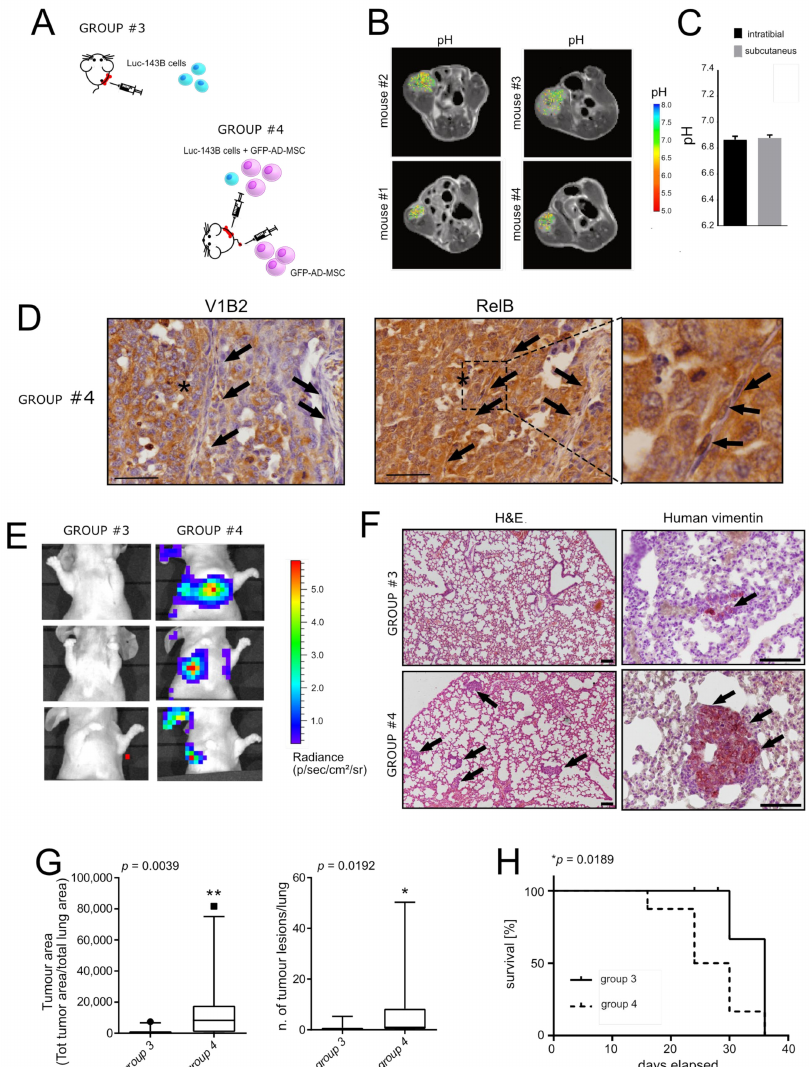
Figure 3. Intratumoural acidosis and co-injection with GFP-AD-MSC in intratibial OS promotes the expression of IL6 and fosters lung metastasis. ( A ) Representative scheme of the experimental animal trial n. 3 (see Table 1); ( B ) Representative tumour extracellular pH maps for intratibially injected OS xenografts, as measured by CEST-MRI; ( C ) Comparison of the intratumoural pH value of subcutaneously injected xenograft with luc-143B cells (group #1, see Table 1), and intratibially injected xenografts with luc-143B/GFP-AD-MSC (group #3, see Table 1), as measured by CEST-MRI (Mean ± SEM); ( D ) Representative images of the immunostaining of V1B2 V-ATPase and of RelB of intratibially injected xenograft after the co-injection of GFP-AD-MSC and luc-143B OS cells (group #3, see Table 1). RelB immunostaining image with further magnification is shown in the right rectangle (arrows indicate fibroblast-like cells, the asterisks indicate the area with possibly the low pH value since it is highly positive for V1B2 staining). Note the RelB nuclear localisation was found in cells with fibroblast-like morphology; ( E ) Images of the growth of lung metastases in three representative mice for each group of animal trial 4, with intratibially injected luc-143B cells (group #3), after 15 days, as monitored using bioluminescence imaging to which all the data shown are relative, and luc-143B cells co-injected with GFP-AD-MSC (group #4) (see Table 1); ( F ) Representative images of H&E staining (left panel) and of human vimentin immunostaining (right panels) of tissue sections of the lung (scale bar 100 µ m, black arrows enlighten clusters of human tumour cells); ( G ) Graphs relative to the number of tumour lesions in the lung and to the tumour area with respect to the total area of the lung, as assessed by the detection of human vimentin signal and the quantification of positive spots and ROI area, respectively ( n = 10 for group #3, and n = 11 for group #4, ** p < 0.01, Mann–Whitney U test, median and percentiles are shown); ( H ) Survival curve (lung disease-free). Uncensored events were considered when the analysed mice were positive to both luciferase assay and vimentin signal in the lung (Kaplan–Meier curve, Log-rank Mantel–Cox test, * p <